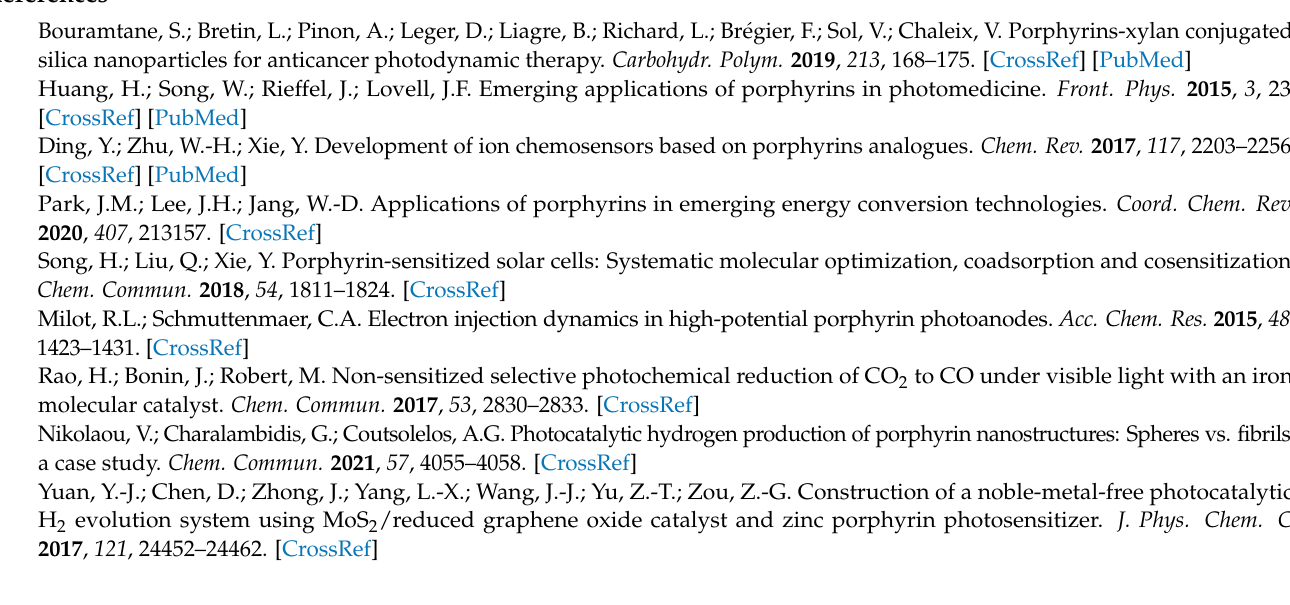
Figure S6: HRMS-ESI Spectrum of TPPF19NH(CH2)6NH2; Figure S7: 1H NMR Spectrum of Dyad 1 (500 MHz, CDCl3); Figure S8: 19F NMR Spectrum of Dyad 1 (471 MHz, CDCl3); Figure S9: HRMS-ESI Spectrum of Dyad 1; Figure S10: CV of dyad 1 over the whole potential range, includ- ing oxidation; Figure S11: CV in reduction of TPPF19NH(CH2)6NHBoc Ag/10-1M Ag+, checked against ferrocene); Figure S12: CV in reduction of TPPF19NH(CH2)6NH2 Ag/10-1M Ag+, checked against ferrocene); Figure S13: Fluorescence emission spectrum of dyad heptazine-porphyrin in DCM (black) and dioxane (red), upon 300nm excitation.; Figure S14: CV of aminomethyl(1-adamantanyl)- bis(diethylpyrazolyl)heptazine DDPAH; Figure S15: Absorption spectrum of DDPAH; Scheme S1: Scheme and Synthesis of